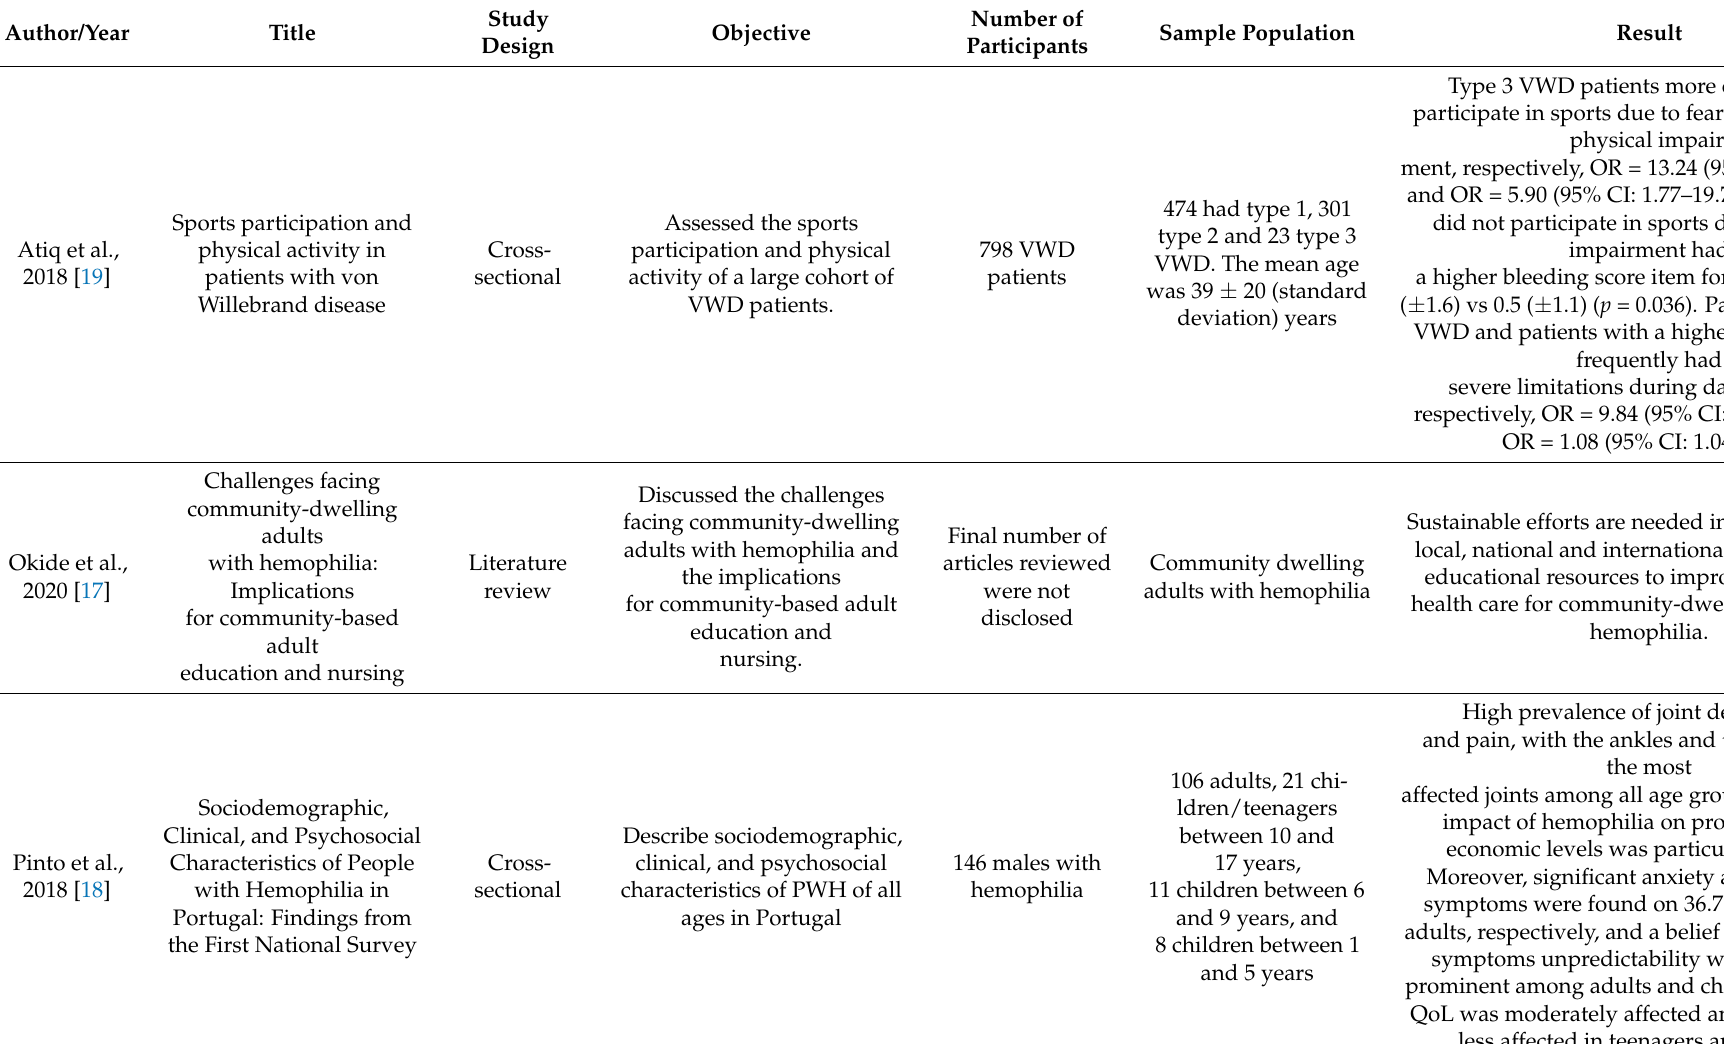
Table 5. Summary of articles found focused on Community and Social